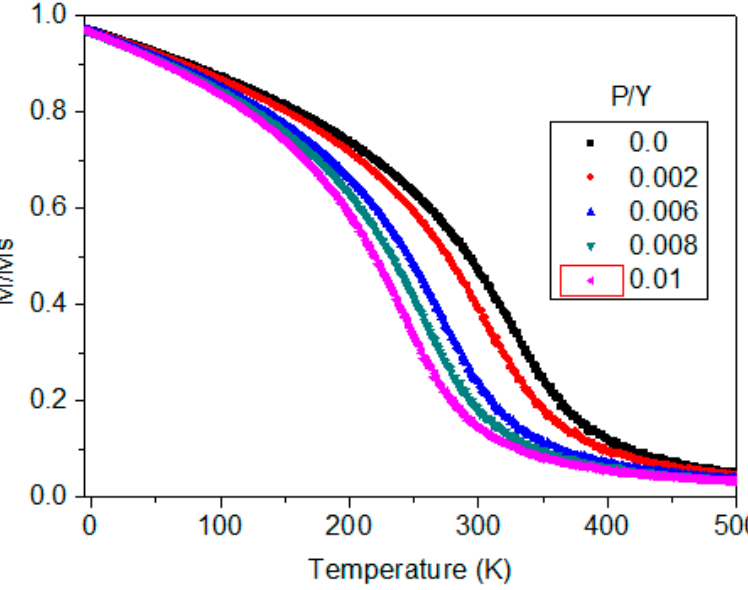
Figure 9. Behavior of the magnetization of an LSMO film ( d = 9 unit cells) at different levels of deformation.